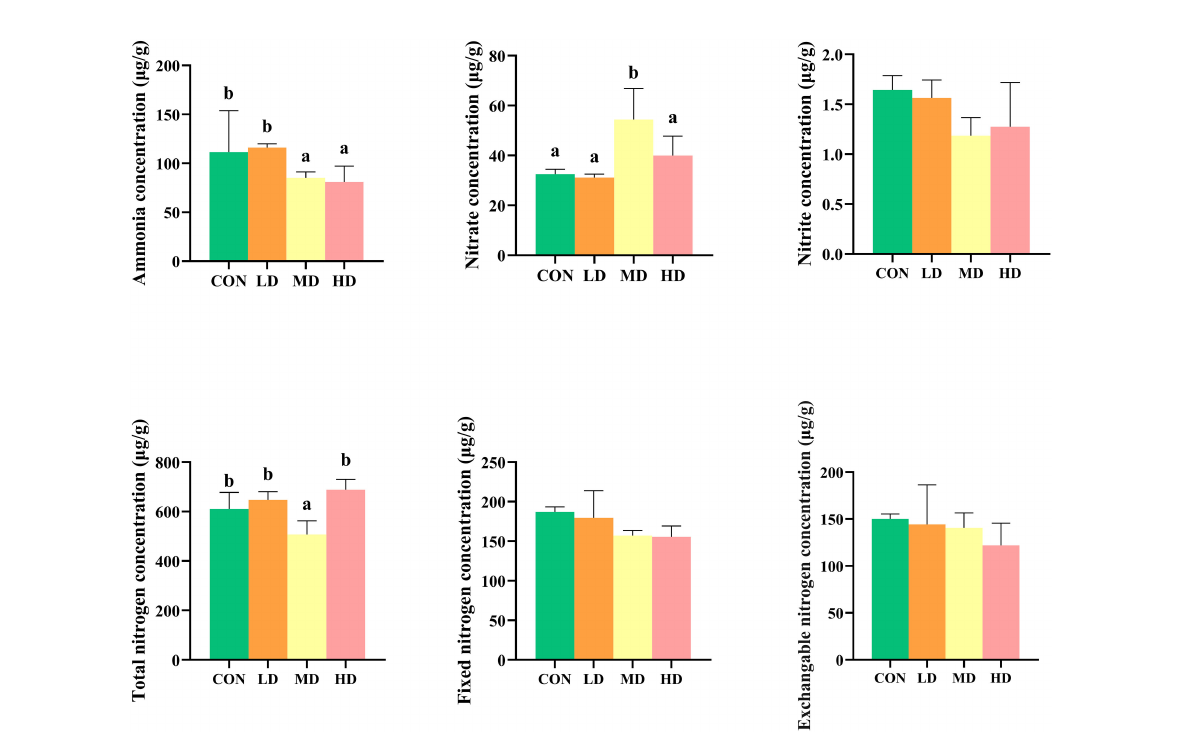
FIGURE 1 Differences in sedimentary nitrogen forms between the CON, LD, MD and HD groups during the experimental period, including ammonia, nitrate, and nitrite concentrations, total nitrogen, fi xed nitrogen, and exchangeable nitrogen. Different lowercase letters represent signi fi cant differences between the CON, LD, MD, and HD groups ( P <